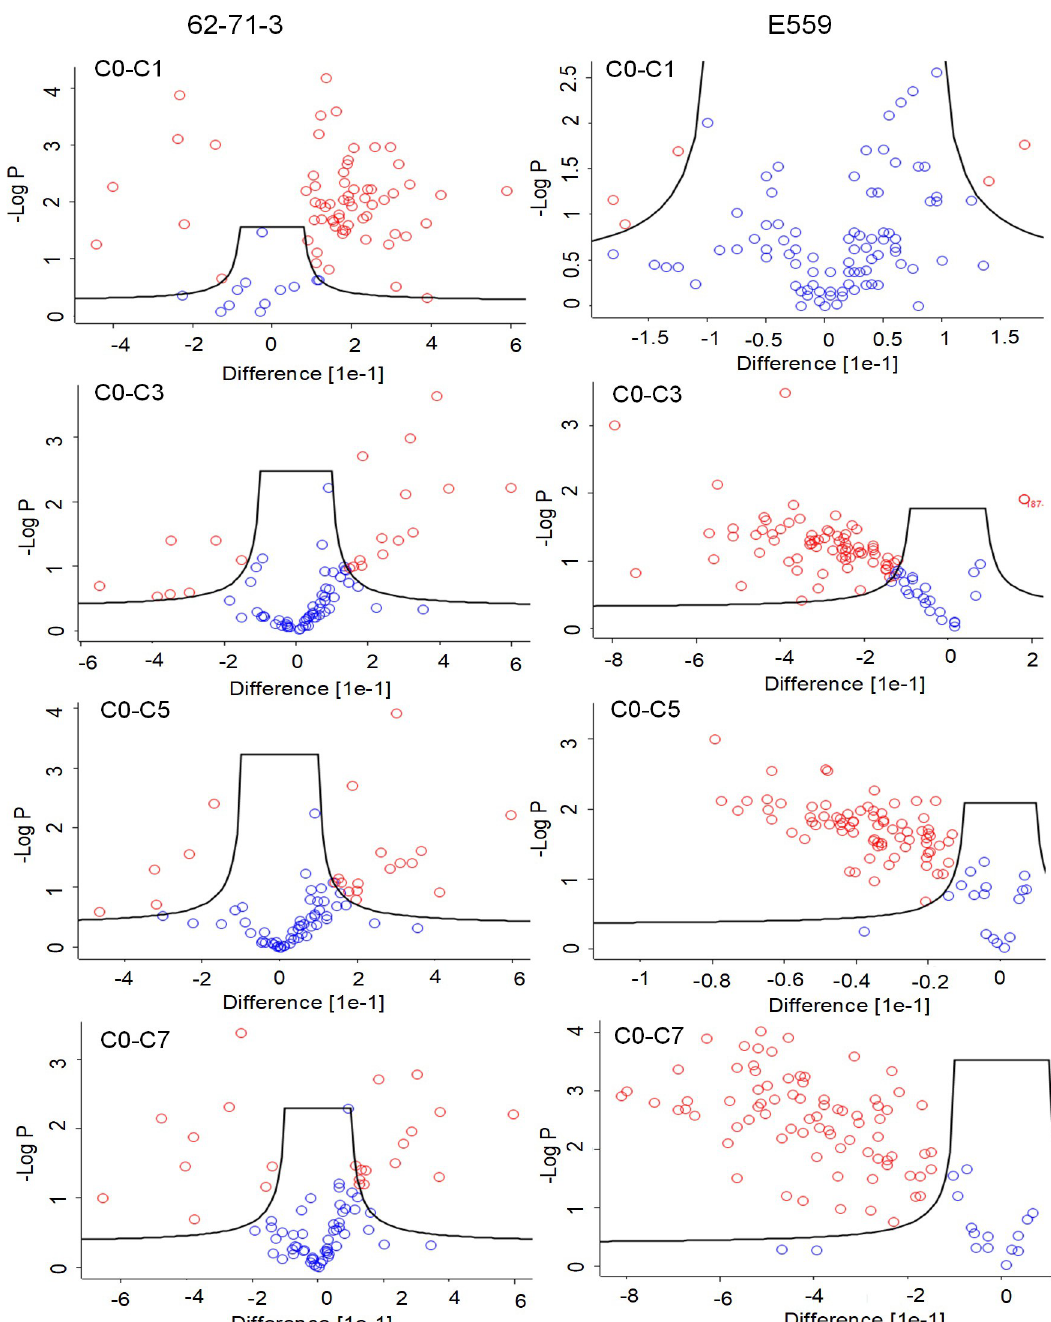
Fig 4. Volcano plots illustrating the effect of freeze-thawing on 62-71-3 (A) and E559 (B) HC peptides. The black solid line delineates peptides that show a significant shift in deuterium incorporation (red dots) versus those that were not affected by F/T (blue dots). Samples were analysed in duplicates. C0 represents non-frozen sample, C1, C3, C5 represent F/T cycle 1, 3, 5 or 7. The circles with a negative (-) difference indicate increased deuterium incorporation compared to the non-frozen sample. The circles with a positive (+) difference indicate decreased deuterium incorporation compared to the non-frozen sample. The FDR was set to 1%, S0 value was set to 0.1 and adjusted p-value cut off was 0.05.